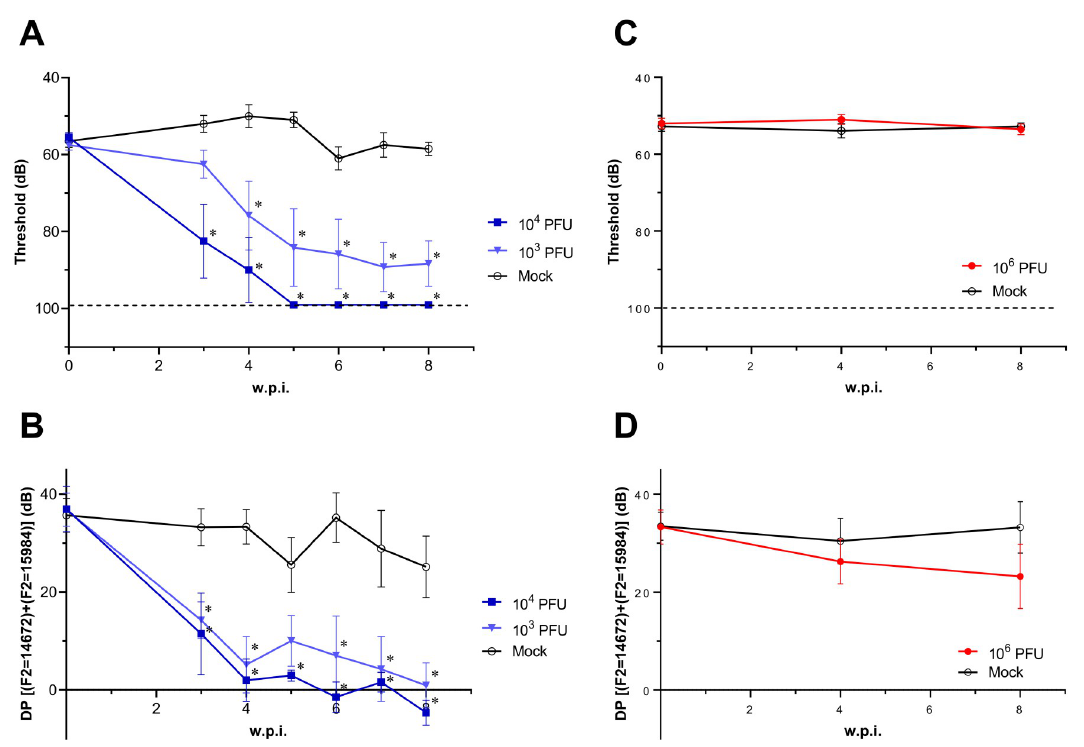
Fig 2. Hearing tests in LASV-infected Stat1-KO or WT mice. The results of ABR (A and C) or DPOAE (B and D) of LASV-infected Stat1-KO (A and B) (n = 6 for 10 3 PFU; n = 4 for 10 4 PFU) or WT mice (C and D) (n = 5) were plotted, respectively. Data were shown using the mean and SEM. The broken lines indicate the limit of detection in ABR (98 < dB). Statistical differences at each time point compared to each mock group were calculated by 2-way ANOVA followed by Dunnett’s post hoc test, and shown in asterisks (p <